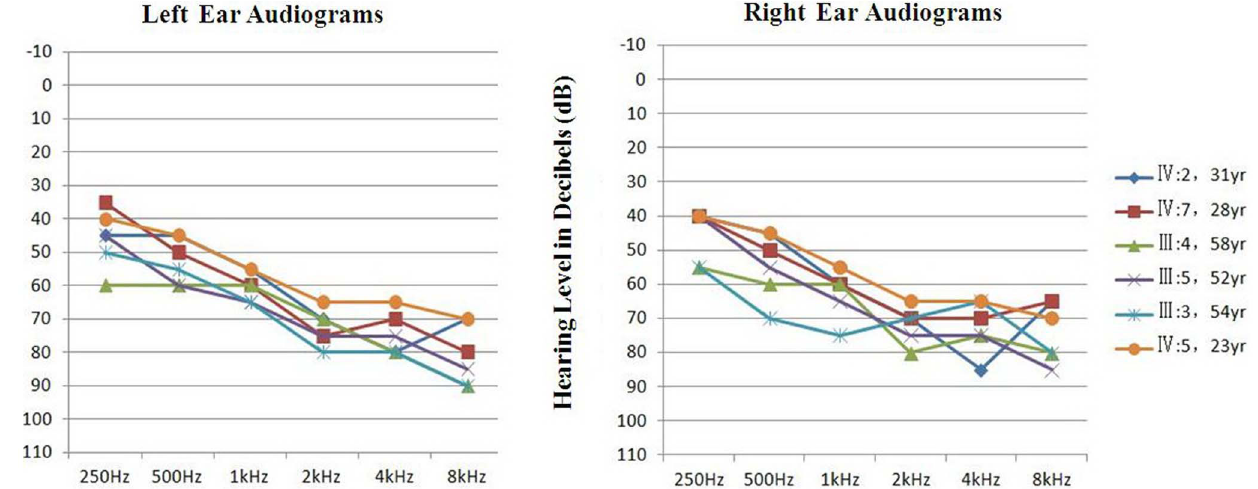
Figure 3. Pure-tone audiograms for the left and right ears of six affected individuals (IV:2, IV:7, III:4, III:5, III:3, IV:5). The numbers to the right are the individuals’